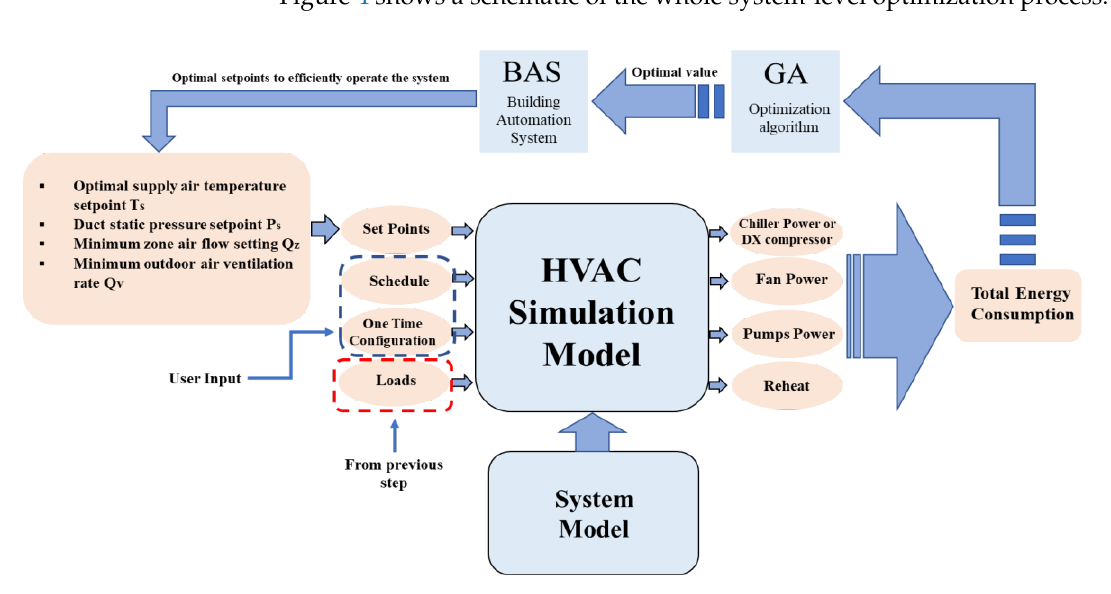
Figure 4. Optimization process schematic diagram.